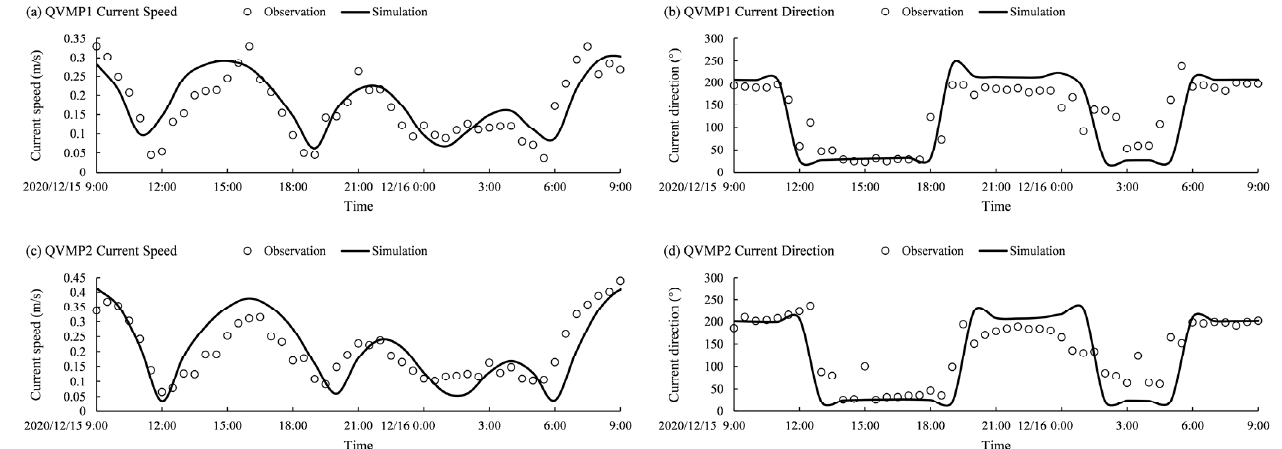
Figure 3. Comparison between the observed and simulated current speed and direction from 9:00 15 December 2020, to 9:00 16 December 2020, at measuring points QVMP1 and QVMP2 for the Qinhuangdao model.